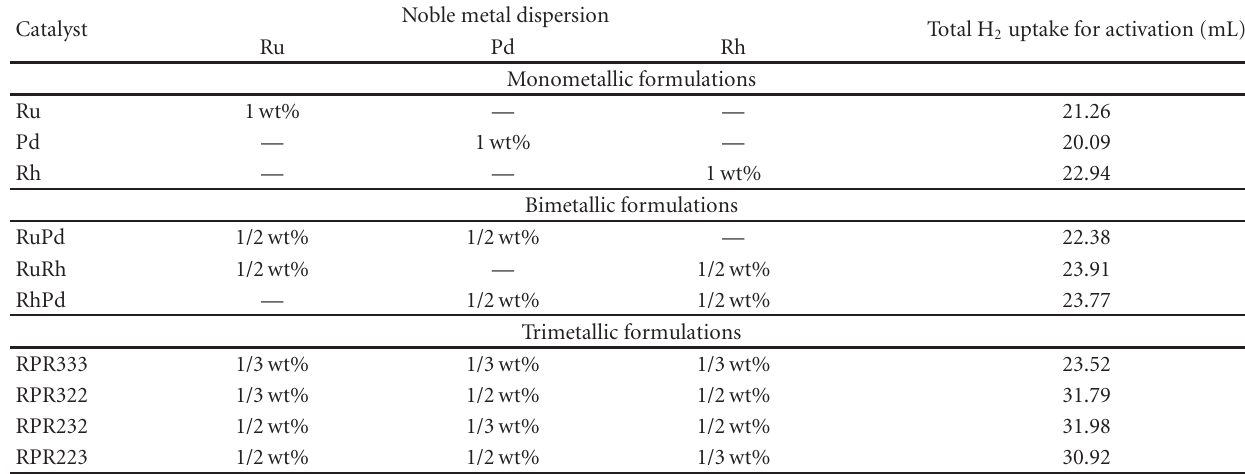
Table 1: TPR characteristics of the catalysts.